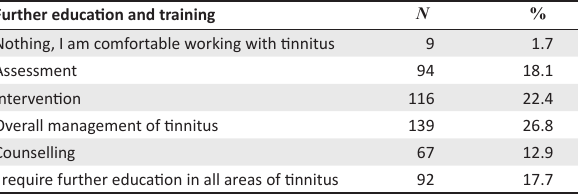
TABLE 2: Further education and training of tinnitus.